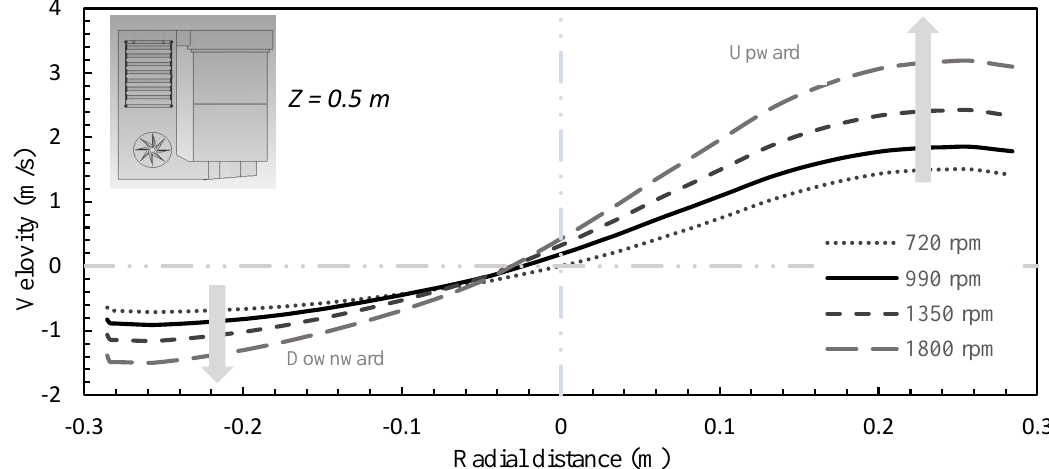
Figure 15. Axial velocity profile at a horizontal line located in the middle of the workspace for the five different rotating speeds studied.